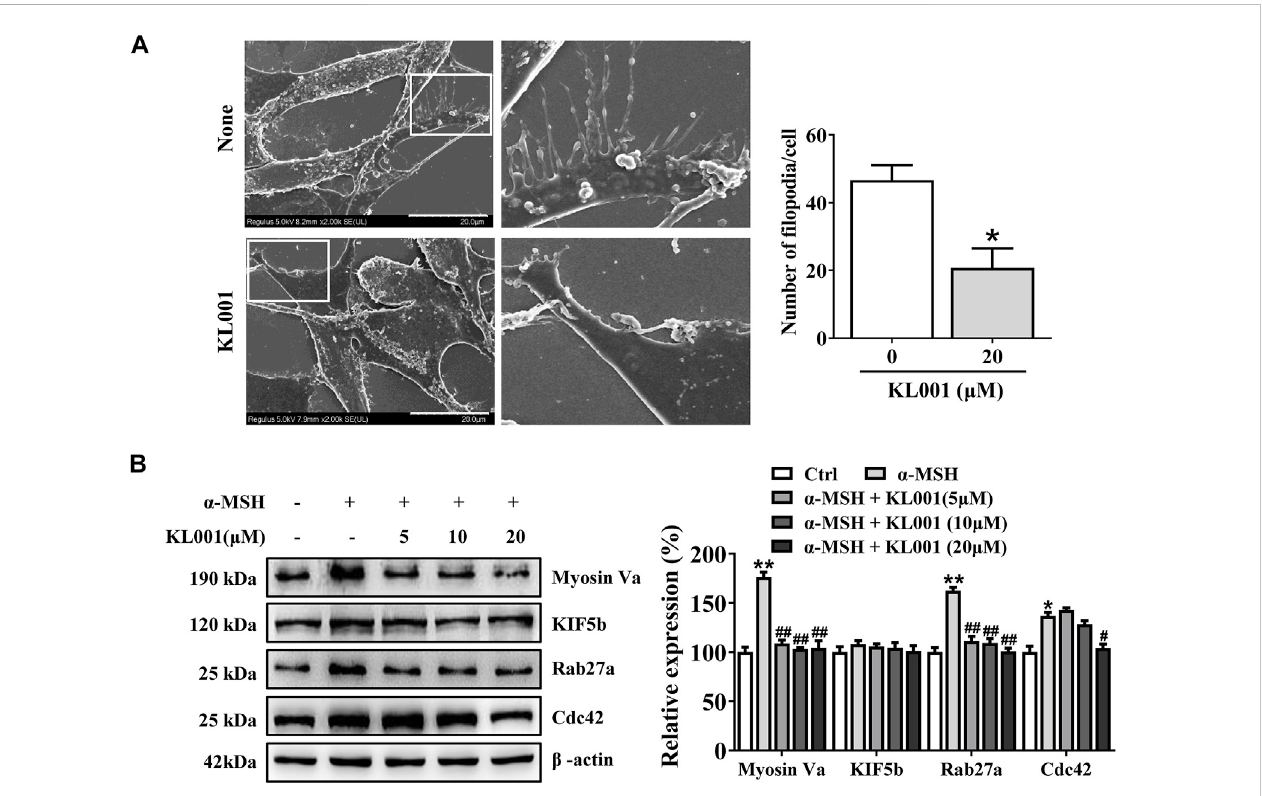
FIGURE 4 KL001 inhibited fi lopodia formation and expression of melanosome transport proteins in B16F10 cells. (A) SEM quanti fi cation of fi lopodia numbers in B16F10 cells. 10 cells/condition were assessed in each of 3 independent experiments. Bar = 20 μ m. (B) The expression levels of related melanin transport proteins were analyzed. Data are expressed as the mean ± SD ( n = 3). * p < 0.05, ** p < 0.01versus non-treated cells. # p < 0.05, ## p < 0.01 versus α -MSH- treated